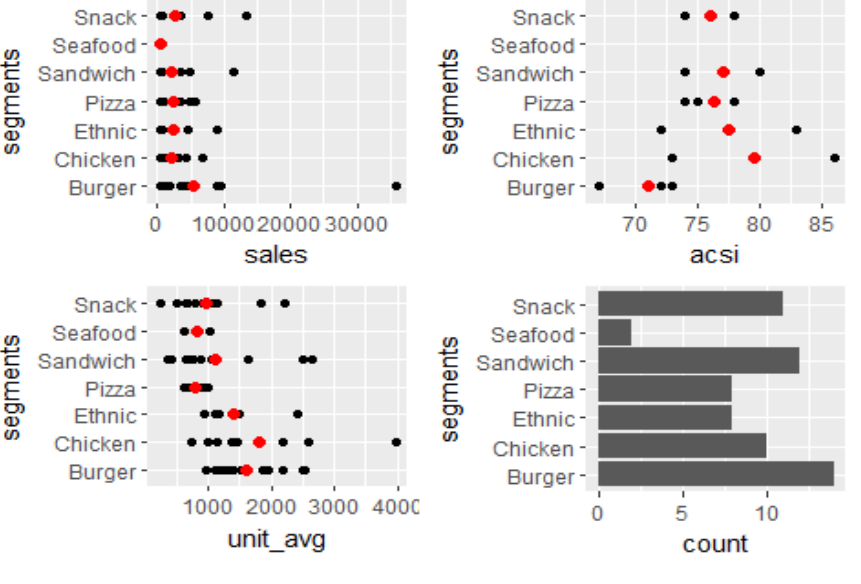
Fig. 2. QSR characteristics by segment